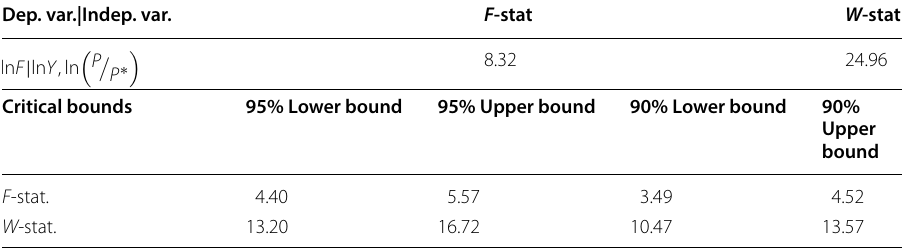
Critical bounds and the respective F -stat and W -stat are computed using Microfit 5.01 (Pesaran and Pesaran 2009) with intercept and dummy